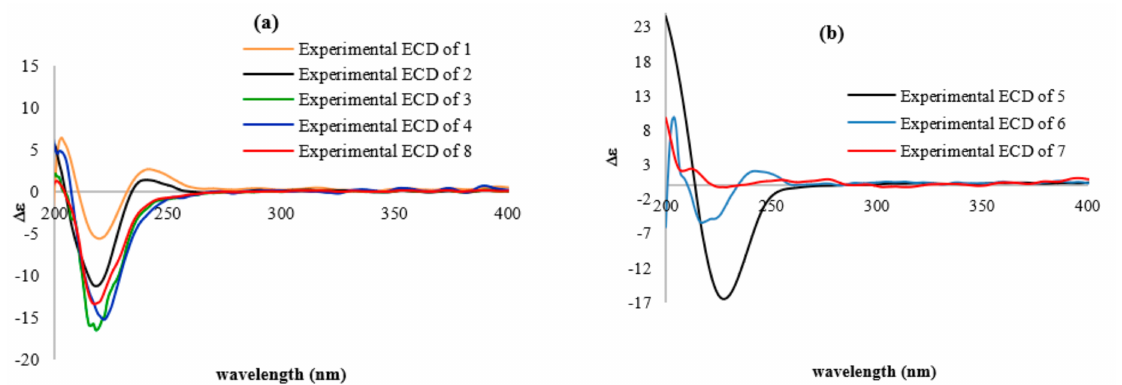
Figure 6. ( a ) Comparison of ECD spectra (black line, experimental ECD of compound 2 ; orange line, experimental ECD of compound 1 ; green line, experimental ECD of compound 3 ; blue line, experimental ECD of compound 4 ; red line, experimental ECD of compound 8 ). ( b ) Experimental ECD spectra (black line, experimental ECD of compound 5 ; blue line, experimental ECD of compound 6 ; red line, experimental ECD of compound 7 ); all compounds were recorded in